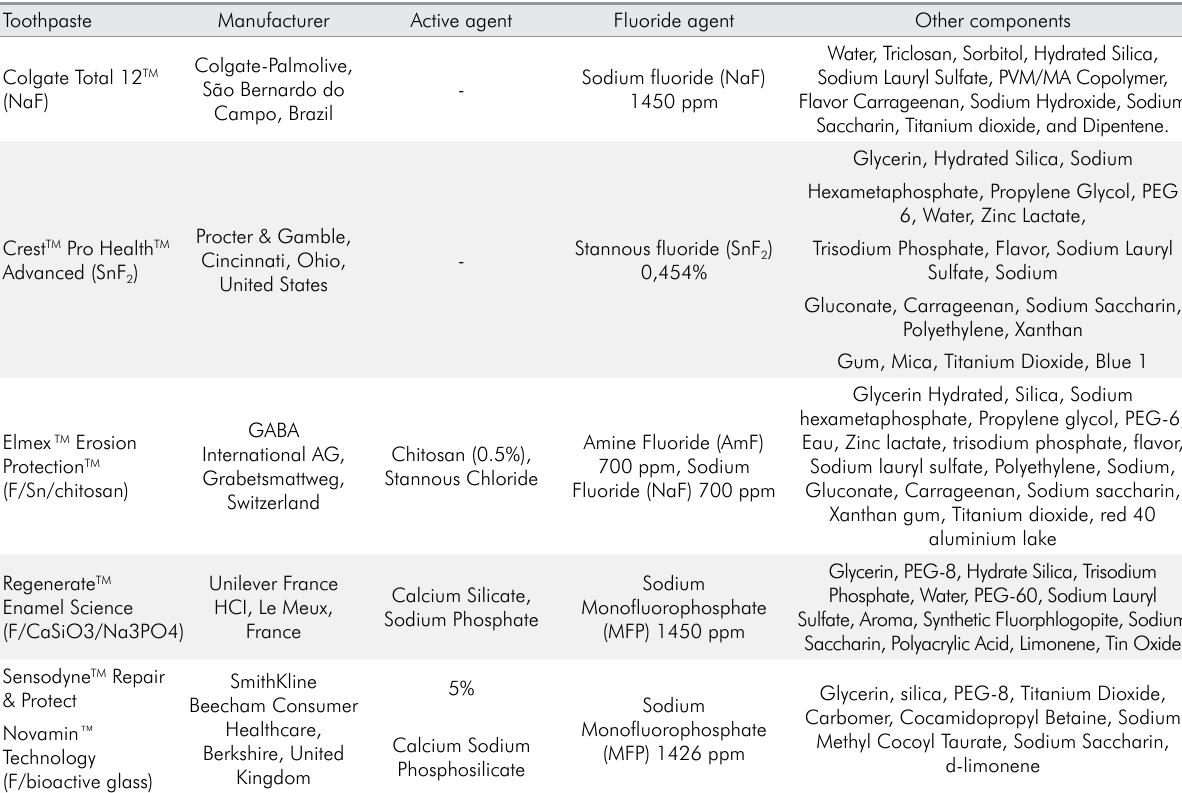
Table 1. Products, manufacturers, and components of toothpaste.